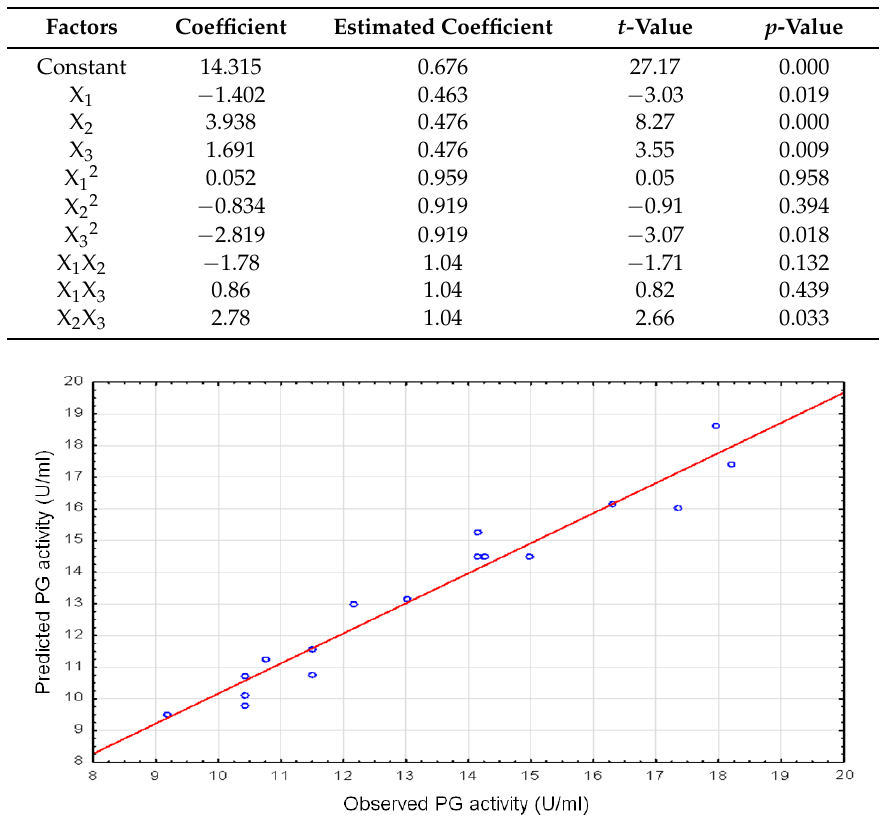
Figure 1. Parity plot showing the distribution of experimental data versus predicted value by the model for potentiation of PG activity.